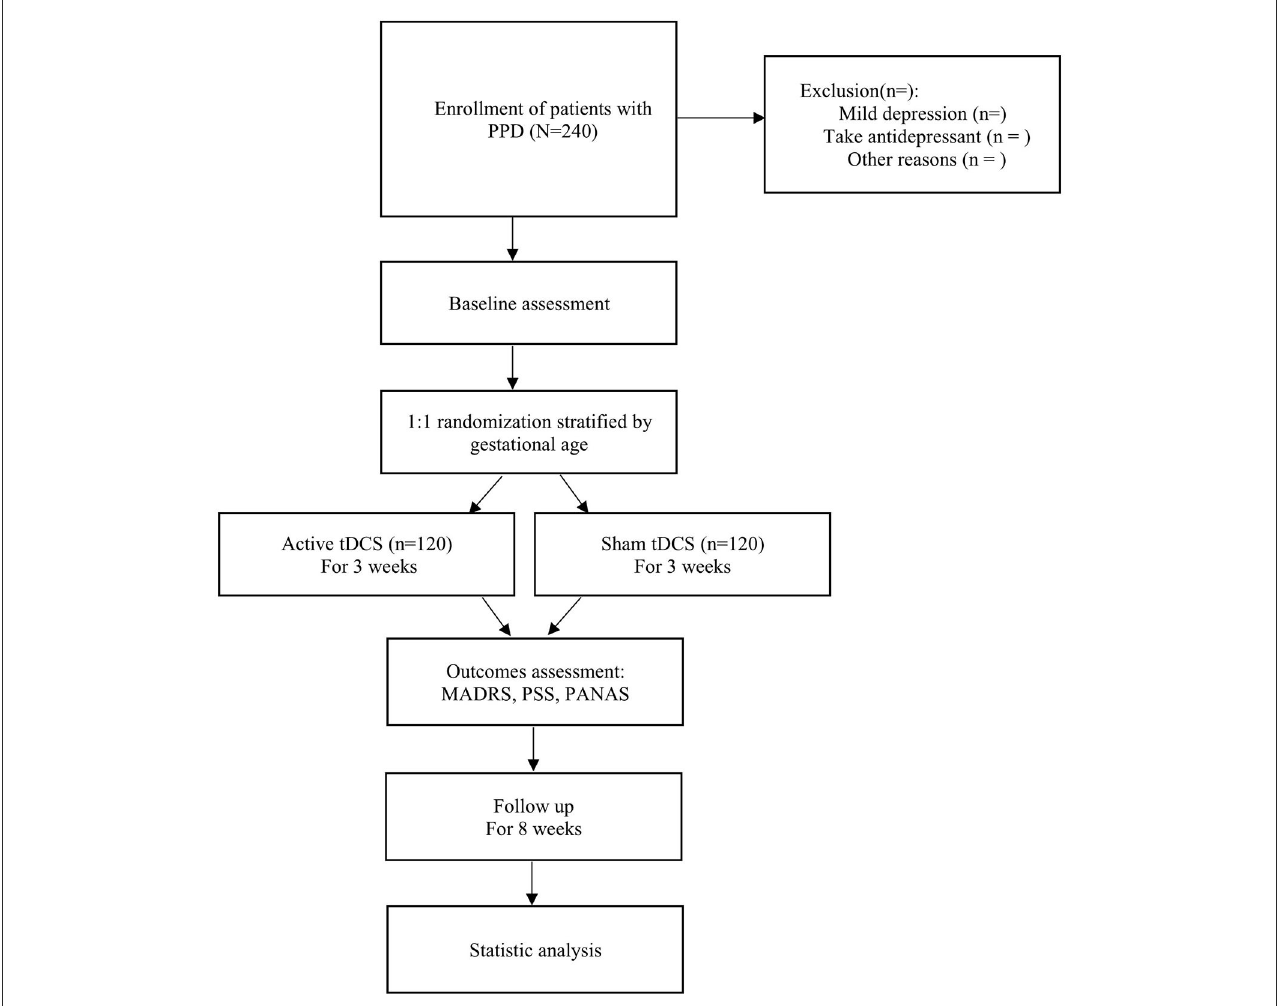
FIGURE1 A flow diagram of the trial design. First, eligible patients with PPD are recruited and a baseline assessment is conducted. Then, patients are divided into the intervention and control groups (active tDCS or sham tDCS) randomly and research is implemented for 3 weeks, and outcomes are recorded timely. Finally, patients are followed up for 8 weeks for statistical